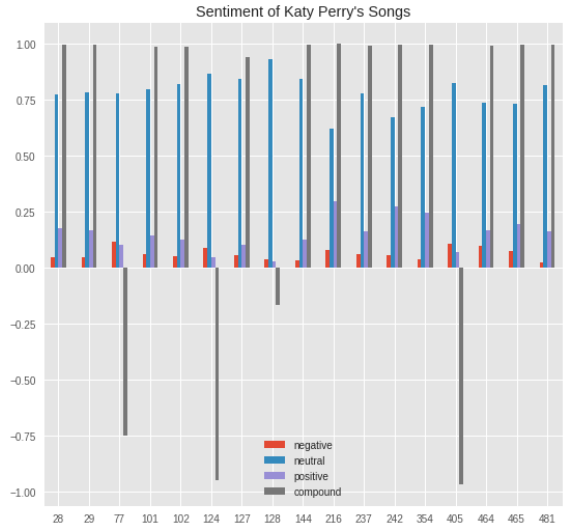
Figure 9. Sentiment plot highlighting the sentiment of Katy Perry’s songs lyrics